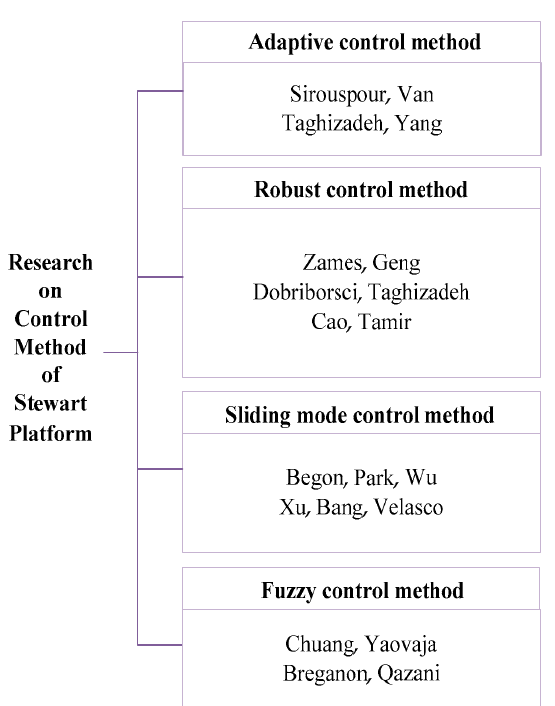
Figure 12. Studies on control methods of the Stewart Platform [54,76,88,91–107].